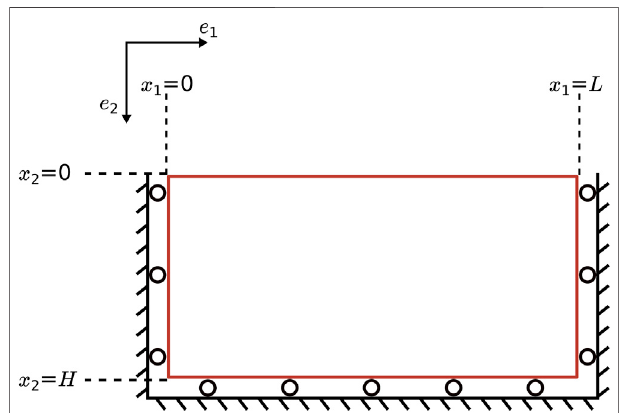
FIGURE 2 | Reference con fi guration of the desiccation